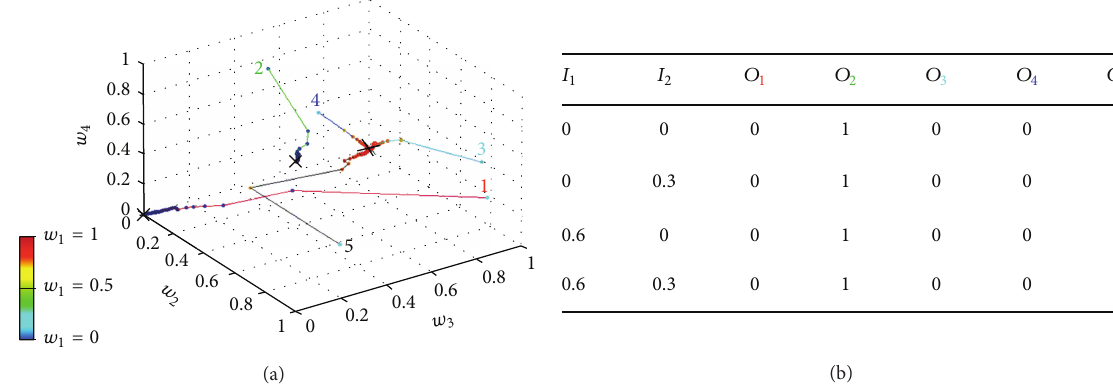
Figure 6: Evolution of gate circuit parameters with only synaptic plasticity. (a) Five computer simulations (five colors of narrow lines) representing synaptic weights evolution during 5000 iterations, once the shifts of activation functions are fixed. Because there are four weights and we have a 3D coordinates system, one of the coordinates, 𝑤 1 , is measured by a scale of colors ranging from 0 to 1. A cross indicates last iteration. (b) Truth table for each one of the